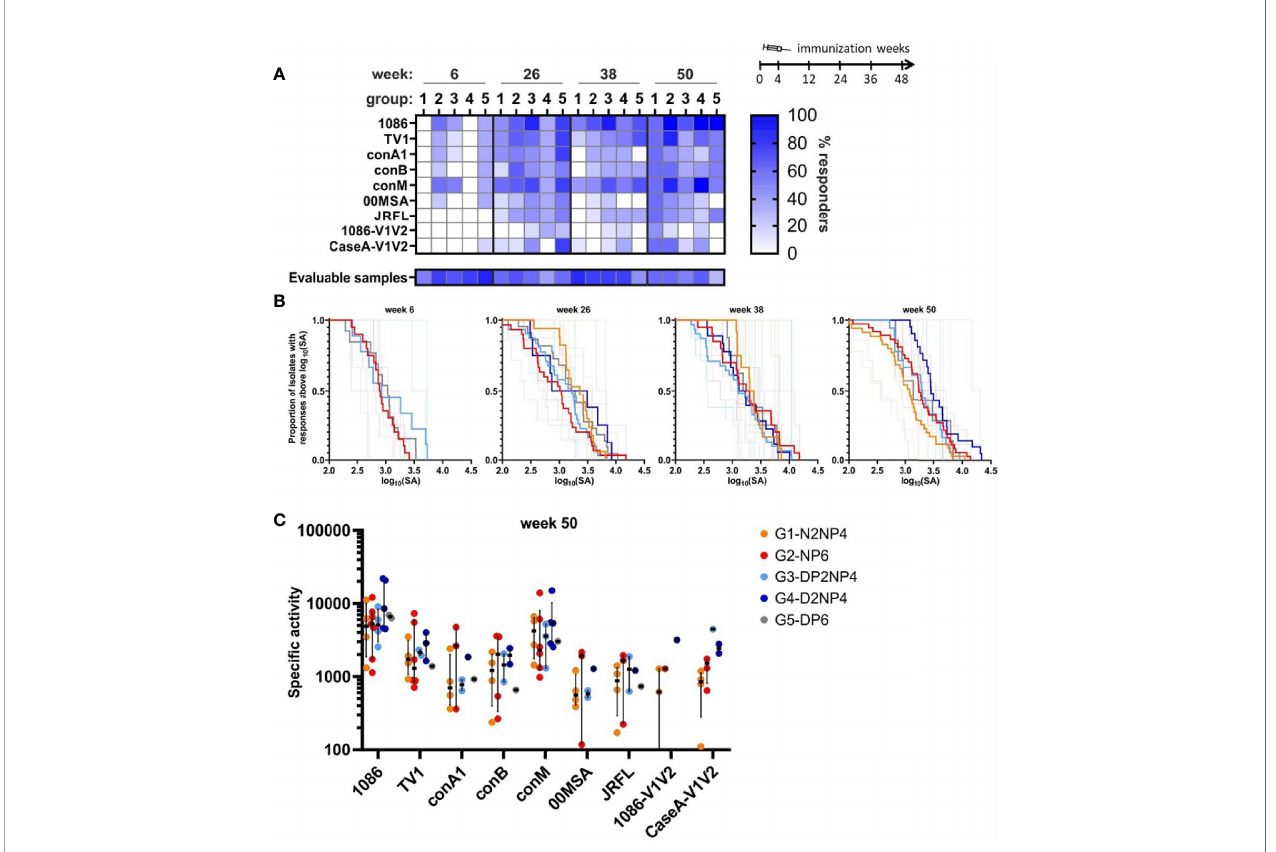
FIGURE 8 | Binding antibody multiplex assay of IgG in fl uid from rectal mucosa. (A) Response rates of animals to the various readout antigens are indicated by color-intensity (scale on the right). The proportion of animals for which evaluable samples were available is shown below the graph (same % scale). (B) Magnitude- breadth plots of the overall mucosal IgG responses (log 10 -transformed speci fi c activity (SA) = MFI×dilution/[c(IgG)/µg/mL]) towards the 9 readout antigens. Bold lines indicate overall group responses, while responses of individual monkeys are shown as thin lines. Groups 1 and 2 were analyzed at week 6 but SA was too low. (C) Comparison of week 50 responses (SA) towards the readout antigens. Responses of individual monkeys for which evaluable samples were available are shown as colored dots and median and interquartile ranges are shown as black